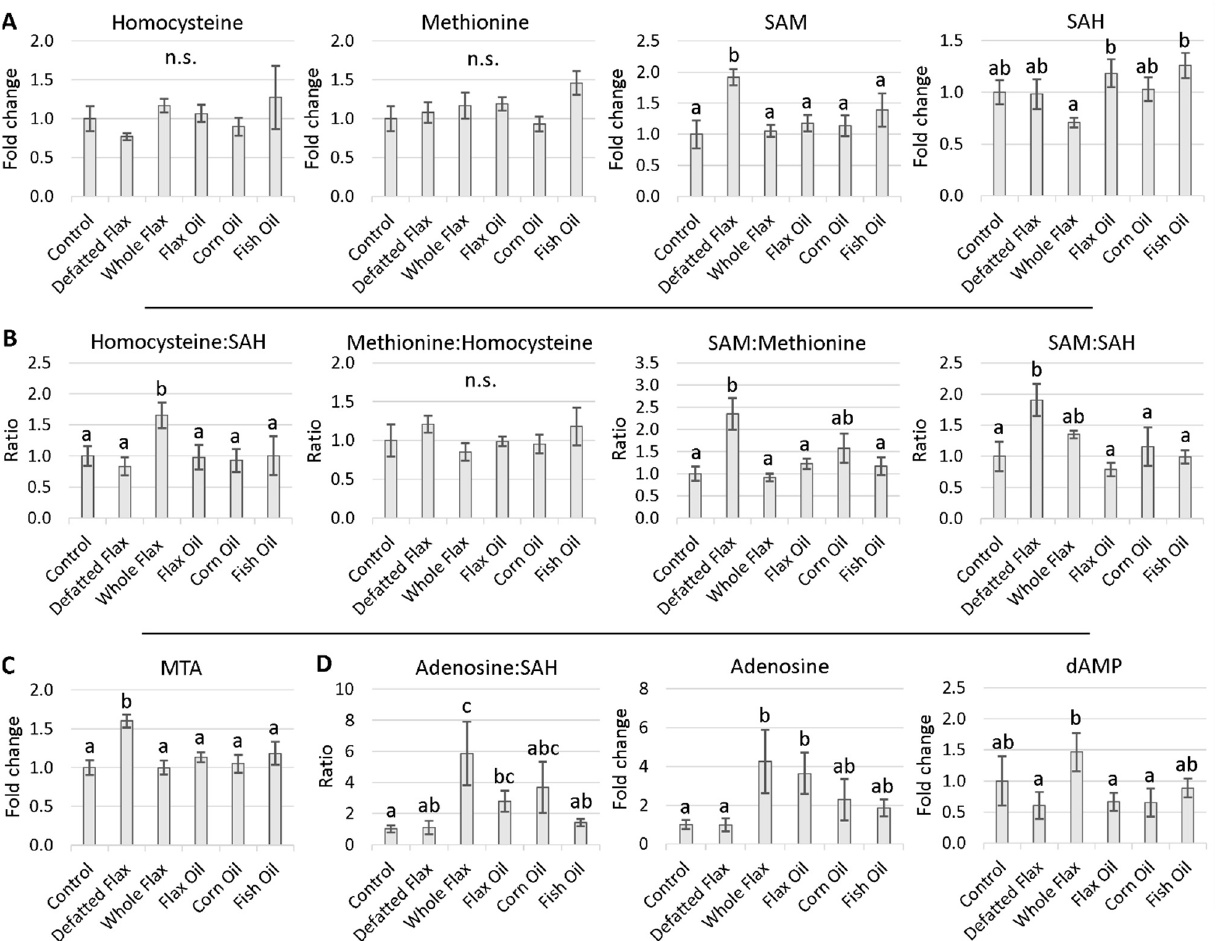
Figure 4 . Plasma estimate of methionine cycle metabolites and associated metabolites: Hen plasma samples were measured via LC-MS/MS. VIP scores of metabolites were analyzed via one-way ANOVA (Duncan’s post-test, p < 0.05). Groups lacking a similar letter (i.e., a,b,c) are significantly different. “n.s.” is used to illustrate a non-significant ANOVA. The four methionine cycle metabolites ( A ) as well as their ratios ( B ) are depicted. Plasma MTA was estimated ( C ), and we have multiple proxy markers to estimate SAHH activity ( D ). The sample size from each group is listed in the Materials and Methods section (Section 5.3). The F-test result for Homocysteine:SAH was p < 0.066. Error bars are +/ − SEM. SAM was not elevated in WFX hens (unlike in DFM hens) (Figure 4A). We suspect